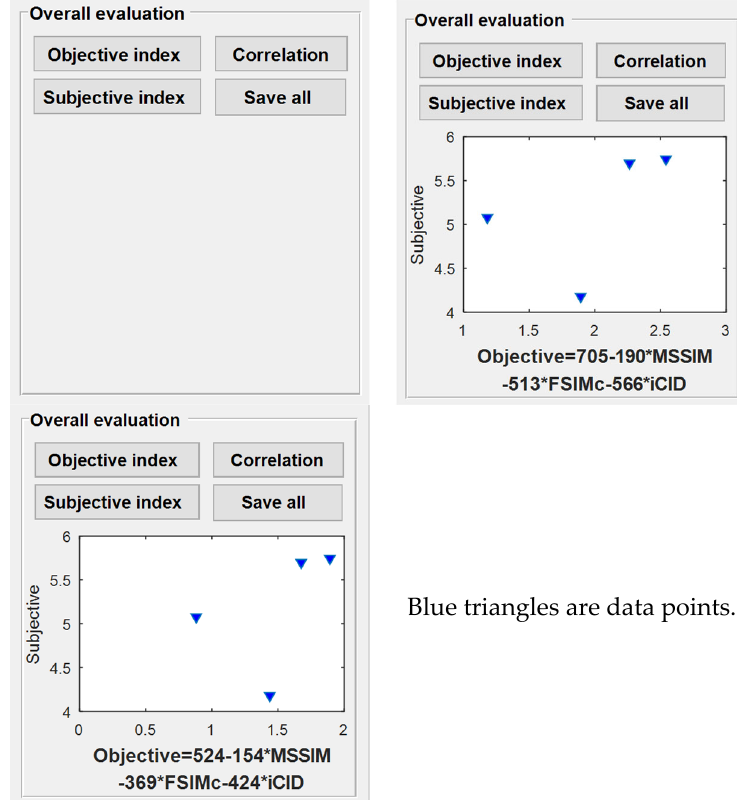
Figure 18. Interface design and its case demonstration in Module 8. Table 8. Types, labels, and roles of controls used in the Module 8 interface.